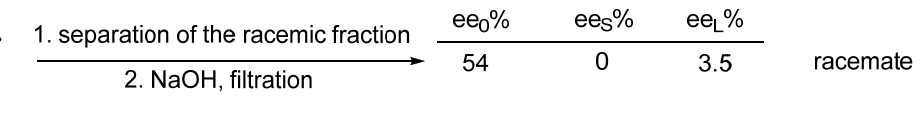
Figure 26. The separated racemic fraction can be resolved again.